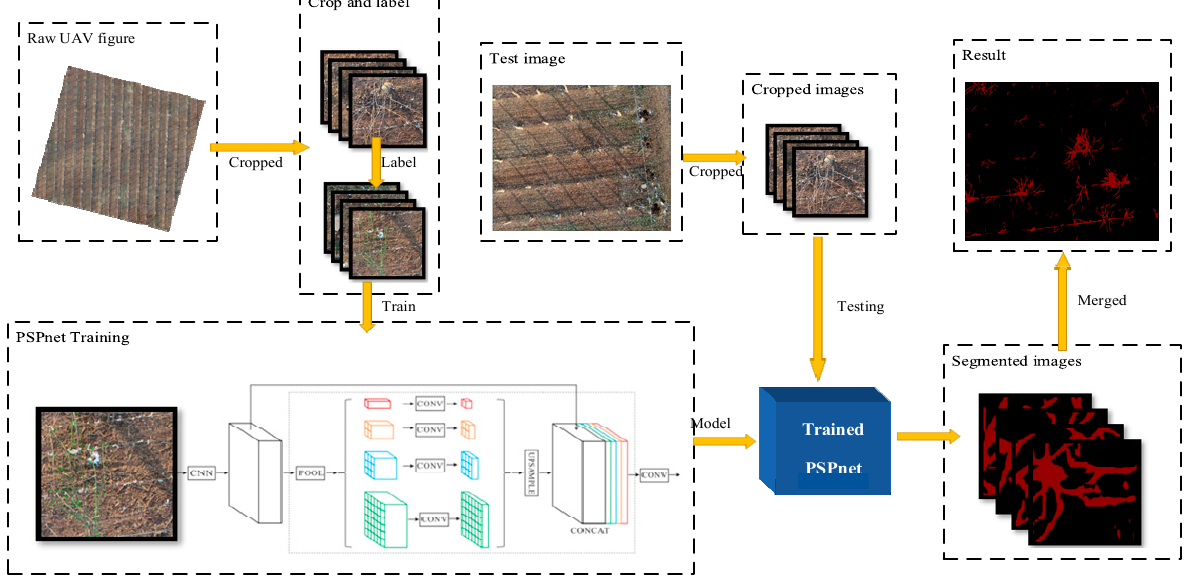
Figure 3. The original UAV image is clipped and labeled, and then input into the PSPnet network for training, and the training model is obtained. The image of the test set is clipped and input into the model to obtain the segmented image. Finally, the segmented image is stitched to obtain the segmented image of the remote sensing image.